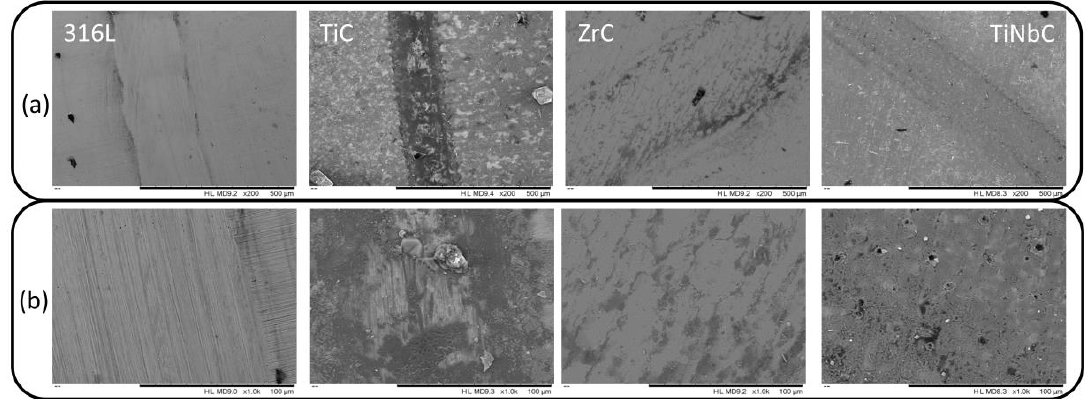
Figure 9. SEM images of wear tracks of the coated and uncoated substrates at the end of the tribological test in 0.9% NaCl at 37 ± 0.5 °C: ( a ) view of the wear track; ( b ) details of the specific area of the wear track.